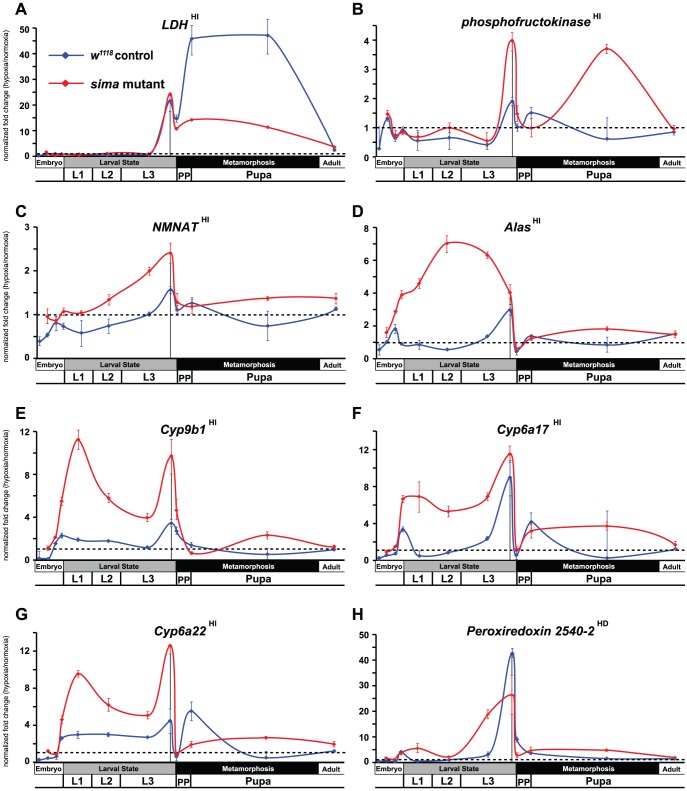
Temporal expression of HIF-independent hypoxic response genes.(A–H) Developmental hypoxic response profiles from qRT-PCR analyses are shown for transcripts that display HIF-independent (A – LDH, B – phosphofructokinase, C – NMNAT, D – Alas, E – Cyp9b1, F – Cyp6a17, G – Cyp6a22) or largely HIF-independent expression (H – Peroxiredoxin 2540-2 – we note that Prx2540-2 displays HD expression for probe set 1631628_s_at in the microarray and is thus classified as such; however, a second, non-overlapping probe set, 1633471_at, which is much more robustly induced in H appears to be from HI action, although its variability is too great to classify in this manner (Table S1). Our qPCR primer set favors HI expression.) Control (w1118) animals or sima mutants were challenged for 6-hrs with 4% O2. Developmental challenge times are identical to those from Figure 3. All values are from experiments performed in triplicate from pools of biological replicates. Values are normalized to rp49 expression and are reported as the relative fold-change of H/N. The dotted line represents no net change in response, or a value of 1.0. The vertical black line in late-L3 is when microarray analysis was performed. Error bars are the SEM. Separate normoxic and hypoxic traces for each transcript surveyed is shown in Figure S4.